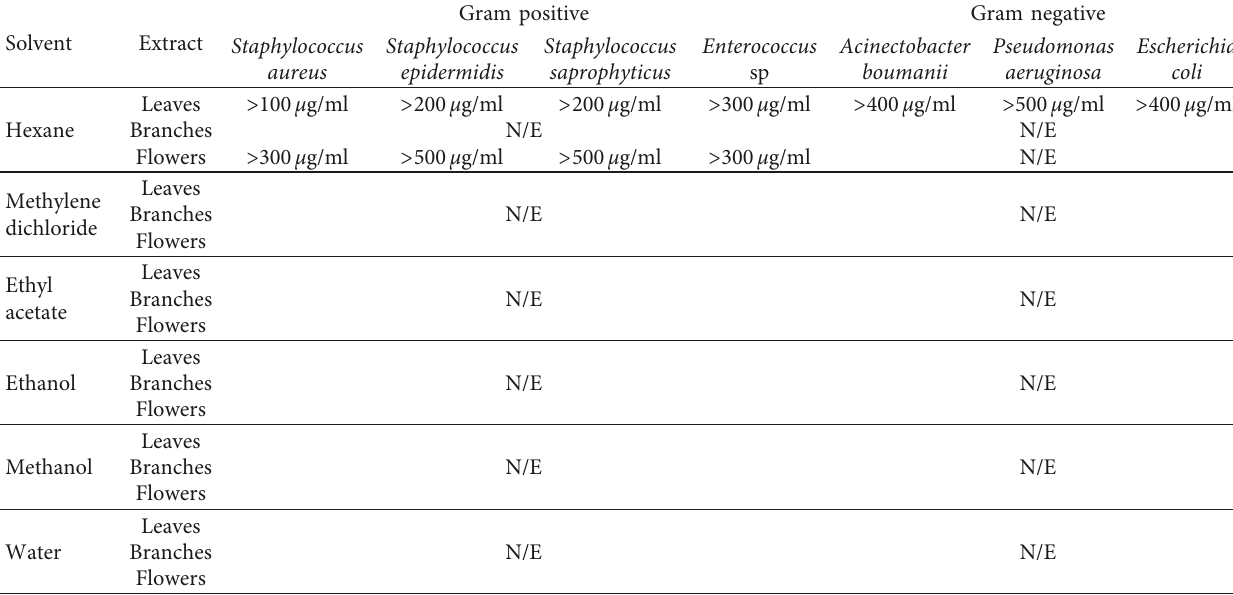
Table 2: Antimicrobial effect of different extracts of Luma apiculata in bacteria of clinical importance.